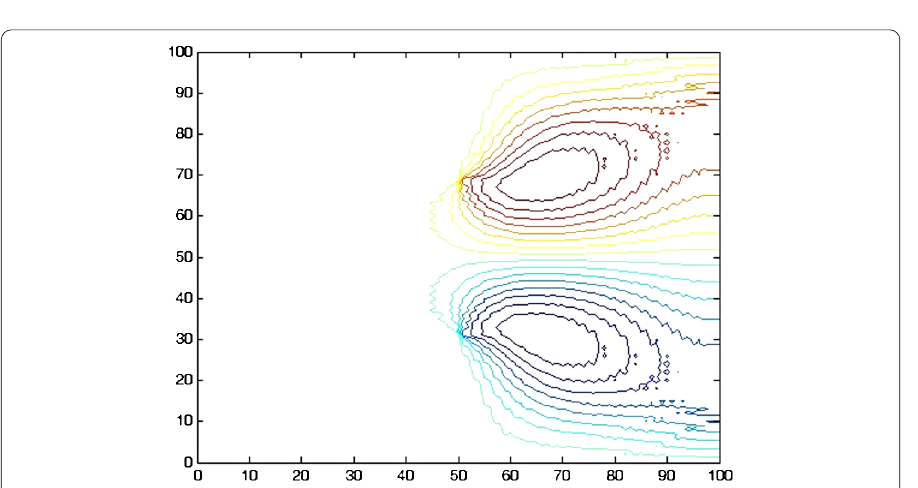
Figure 5 The component F 21 of the SMFE solution of the deformation tensor F at t = 10.